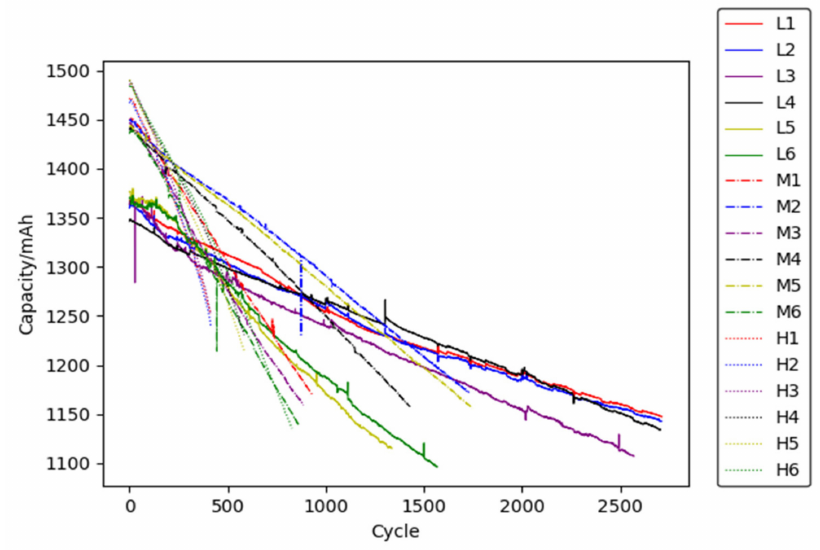
Figure 4. Experimental result of capacity